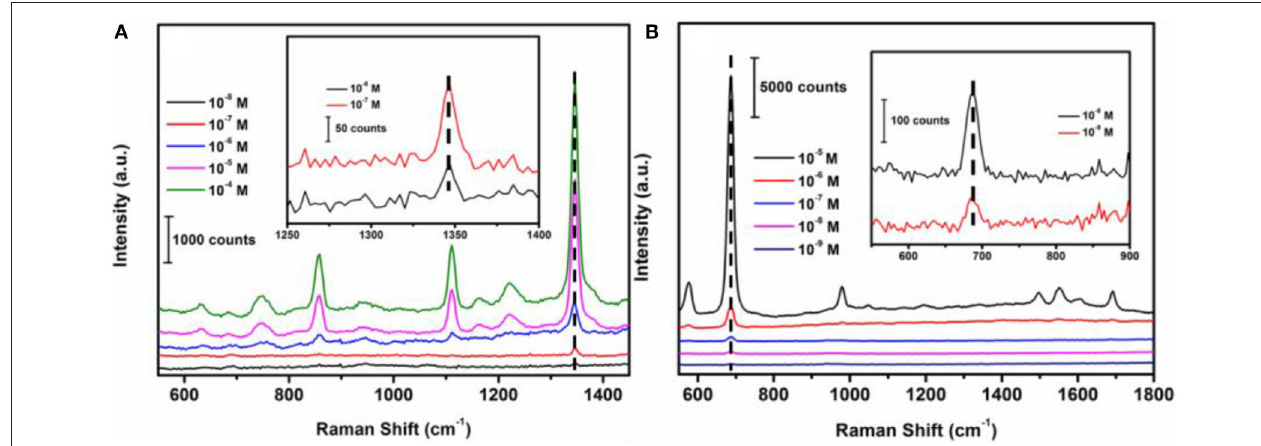
FIGURE 6 | Raman scattering spectra of wax/AuNPs-methyl parathion/AuNPs at different methyl parathion concentrations varied from 10 − 8 M to 10 − 4 M (A) and wax/AuNPs-melamine/AuNPs at different melamine concentrations varied from 10 − 9 M to 10 − 5 M (B) .